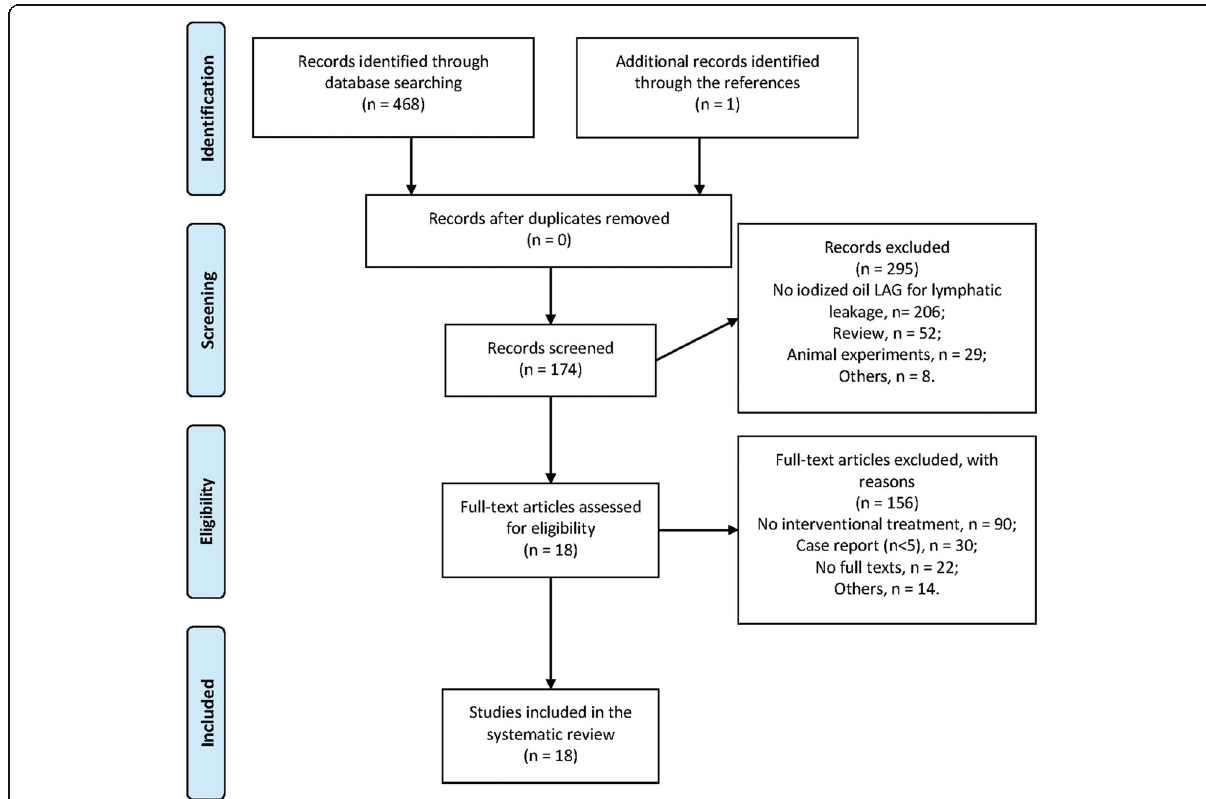
Fig. 3 PRISMA 2009 flow diagram of the retrieved